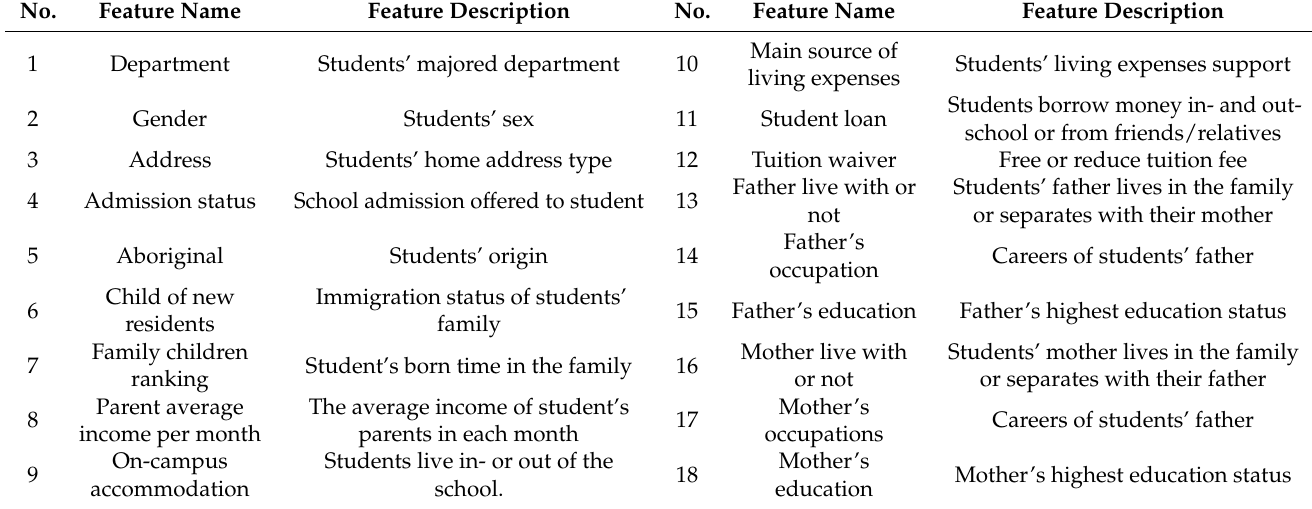
Table 2. The input